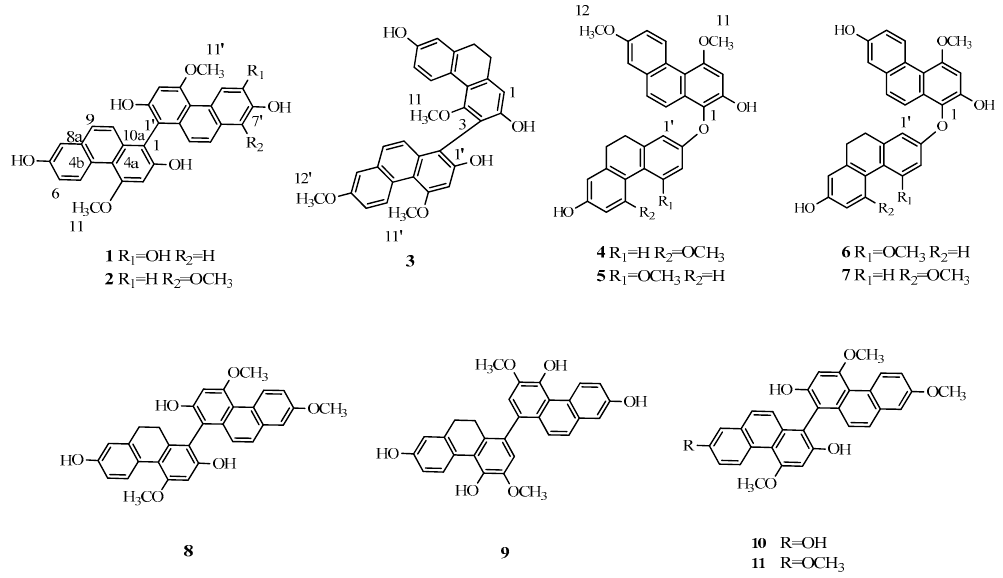
Figure 1. Structures of compounds 1 – 11 isolated from C. appendiculata.